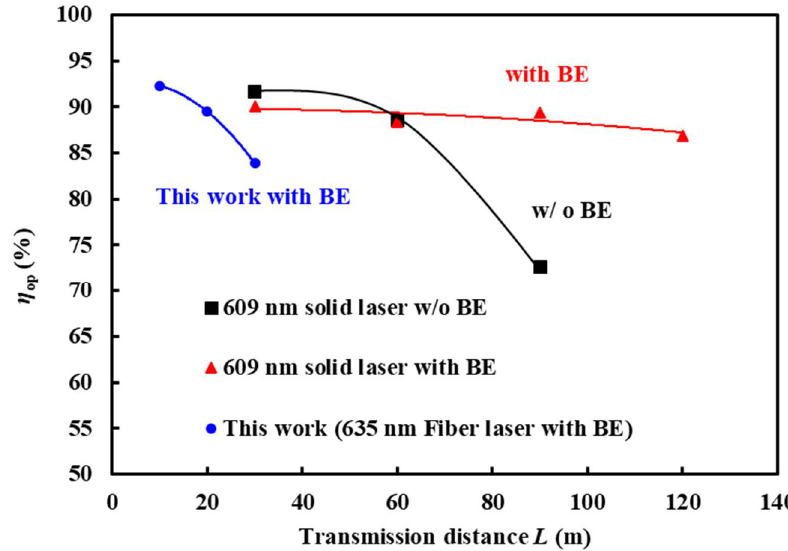
Figure 6. Relationship between optical reaching rate and transmission distance L with and without beam expander. The plots under 609 nm solid laser were calculated from [14].